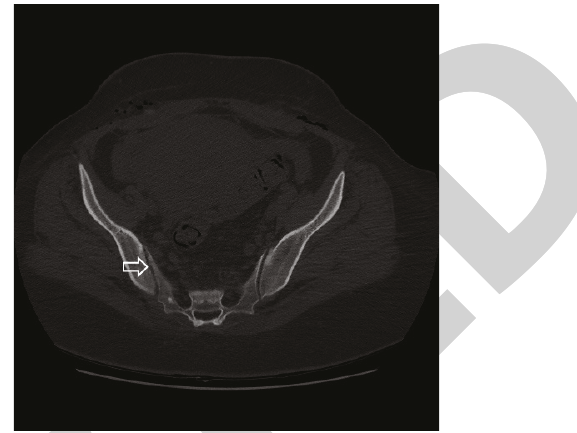
Figure 2: CT image of right sacroiliac junction after